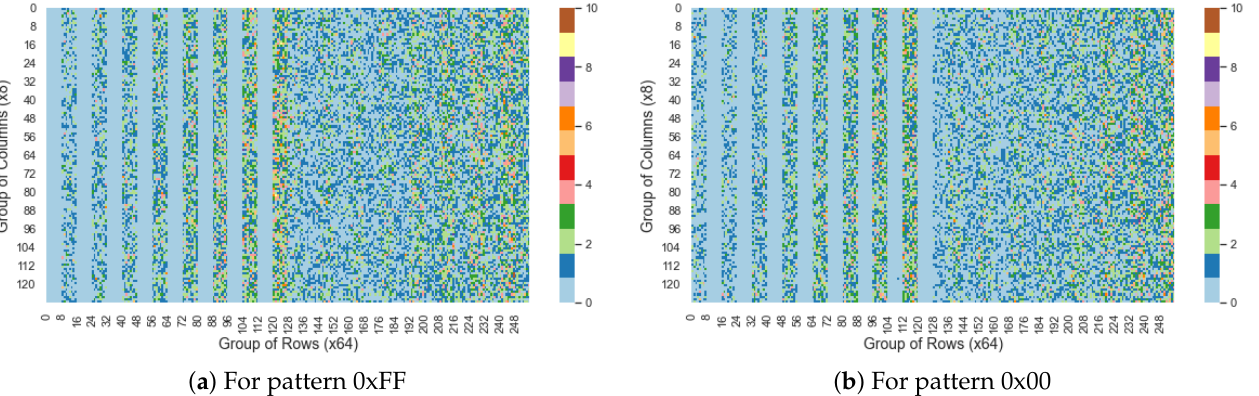
Figure 4. Distribution of retention errors across rows and columns for pattern 0xFF and 0x00 in a Micron module.